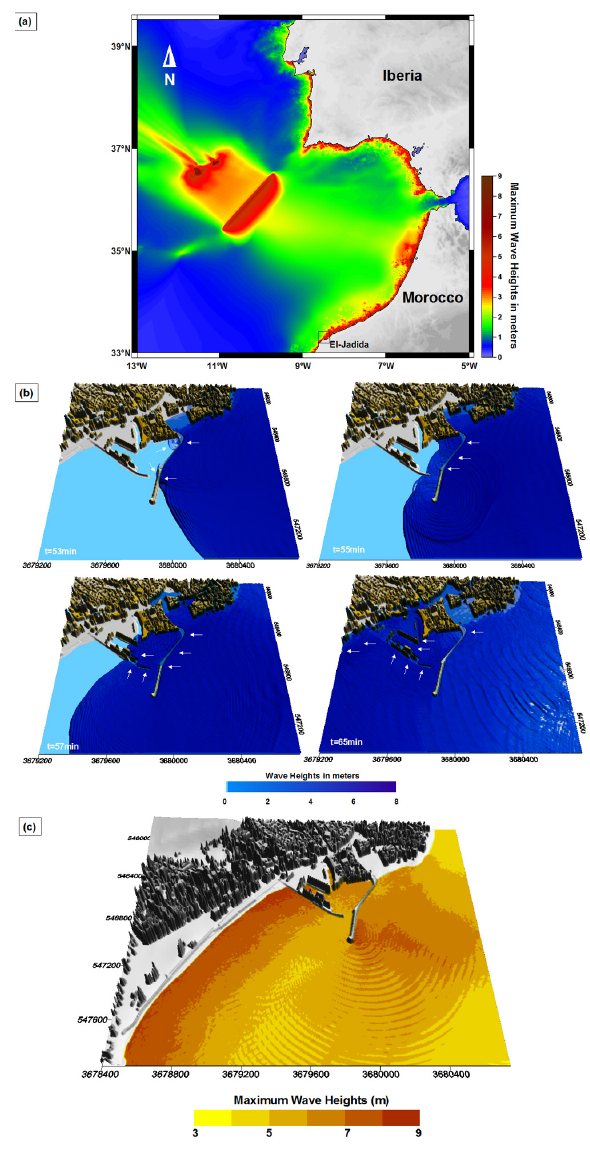
Fig. 6. Tsunami waves’ propagation and near-shore behaviour for the M w = 8 . 5 HS scenario: (a) regional tsunami energy patterns; (b) snapshots of near-shore tsunami propagation at El Jadida site; the white arrows indicate the overtopping locations; (c) maximum wave heights distribution near coasts and the harbour of the studied